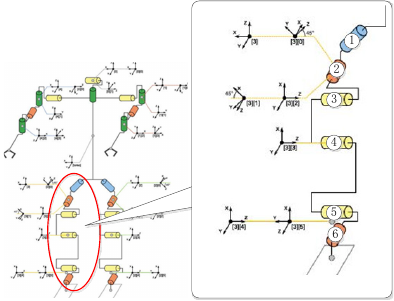
Fig. 4. Diagram of a NAO robot’s joint